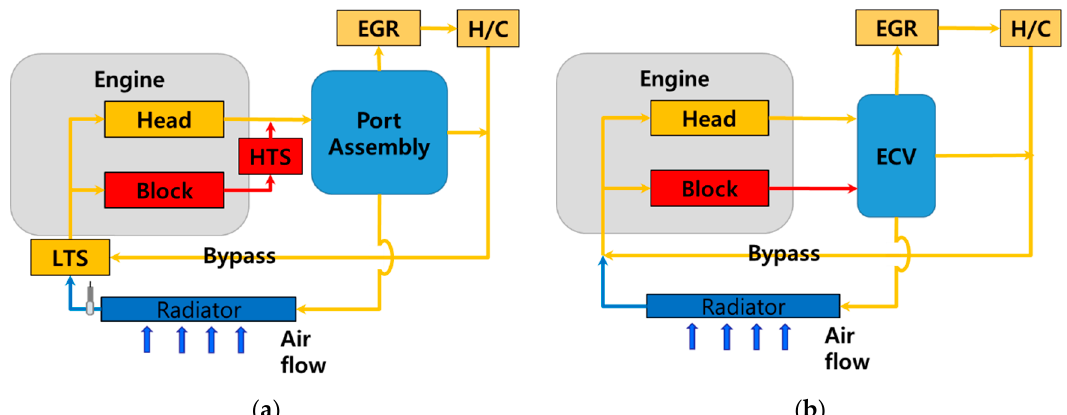
Figure 1. Cooling system schematic comparison. ( a ) Conventional cooling circuit. Conventional cooling system using a mechanical thermostat with separate cooling. Low-temperature Thermostat (LTS) starts opening at 88 °C; high-temperature thermostat (HTS) starts opening at 105 °C. ( b ). Modified cooling circuit. Electric control valve system with both the mechanical thermostats (LTS, HTS) removed. The flow through Exhaust gas recirculation (EGR) and Heater core (H/C) is combined in the bypass.